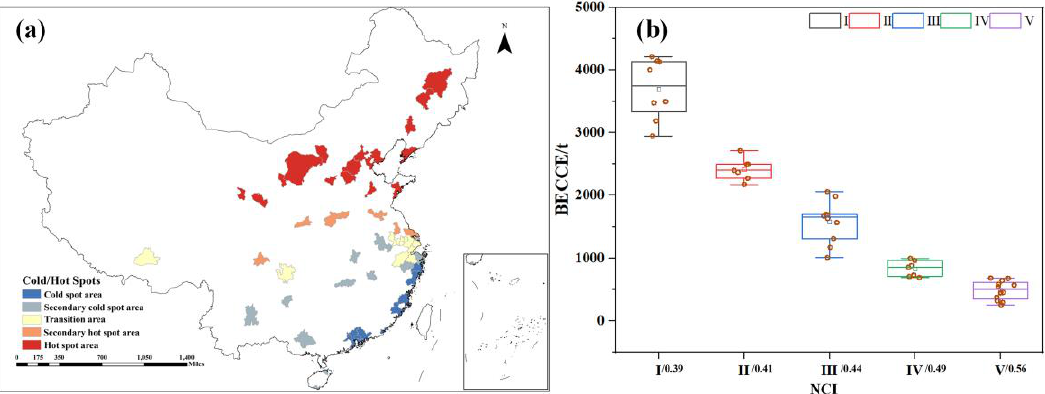
Figure 8. Optimization of the green space compactness. ( a ) Distribution of hot and cold spots of BECCE; ( b ) The relationship between green space compactness and BECCE. Reductions in BECCE are associated with the replacement of GSC of one category with that of another category. (Note: I/0.39, II/0.41, III/0.44, IV/0.49, V/0.56 represented mean of the NCI corresponding to the hot spot, secondary hot spots, transition area, secondary cold spots, and cold spots, respectively. GSC represents green space compactness. NCI was the value of green space compactness. BECCE represents building energy consumption carbon emission. The unit of BECCE is ton).